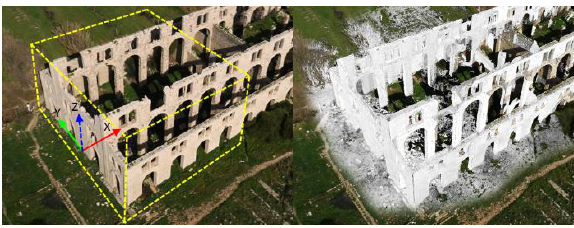
Figure 5. Test area for SBM2017: bounding box and XYZ local reference system (at left), TLS global cloud (at right).